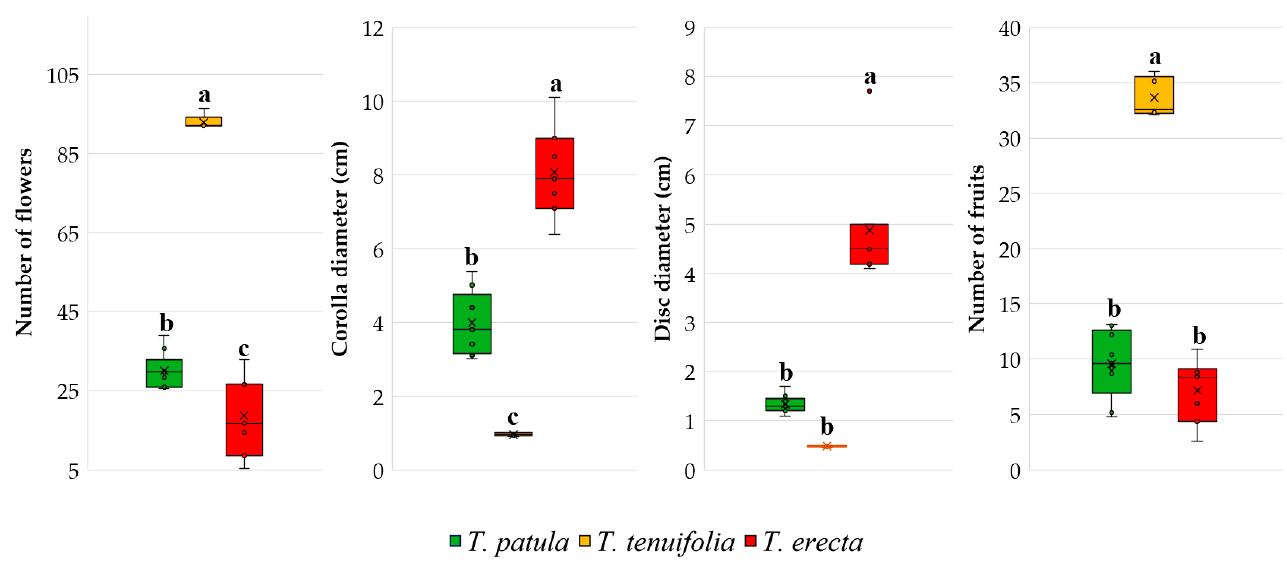
Figure 3. Main traits of the flowers and the number of fruits, based on the cultivars analysed in the three Tagetes species. Each box plot represents minimum, lower quartile, median, upper quartile, and maximum values; in addition, the mean of the data is symbolised with a ‘ ✕ ’ into the boxplot. Different letters among boxplots indicate statistically significant differences for the respective trait, at a significance level of p < 0.05 (Duncan’s test). Table 4. Time (d) since sowing to reach the main phenological phases.